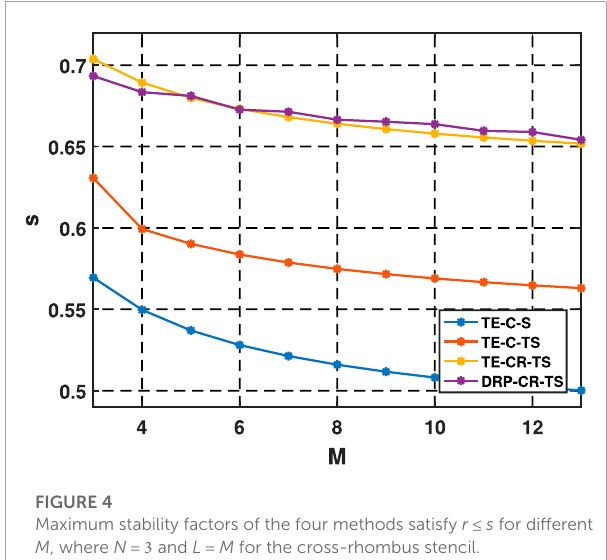
FIGURE 4 Maximum stability factors of the four methods satisfy r ≤ s for different M , where N = 3 and L = M for the cross-rhombus stencil.